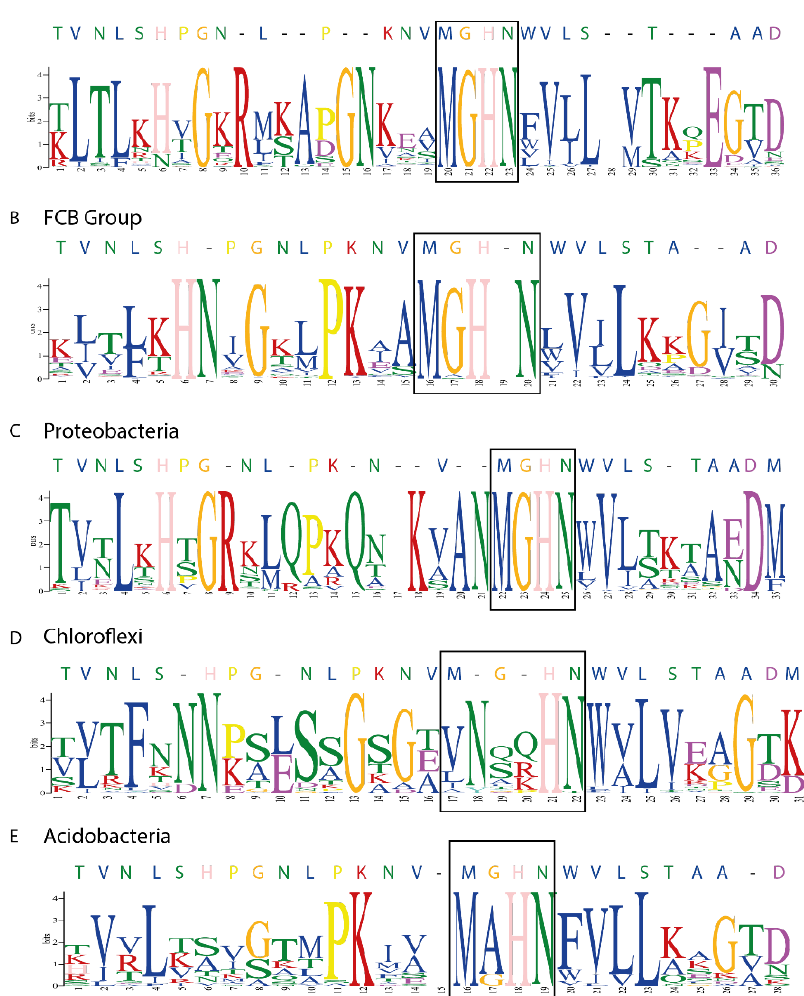
Figure 5. Logogram of p28 domain found in sequences of the major clusters. Logogram of the retrieved p28 domain in PVC superphylum ( A ), FCB group ( B ), Proteobacteria ( C ), Chloroflexi ( D ) and Acidobacteria ( E ). Size of each letter corresponds to the frequency of the related amino-acid in that position. Numbers on the X axis do not refer to the position on the sequence, but to the position of the retrieved alignment. Letters on top of each figure represent the corresponding amino-acid in the P. aeruginosa p28 domain. Black square frame indicates the MGHN tetrapeptide. Nevertheless, just 8 of the retrieved sequences from the phylum Chloroflexi were positive for its presence. Moreover, the p28 domains retrieved from the phylum Chloroflexi were more divergent in respect to the domains present in the other phyla, with even the MGHN tetrapeptide less conserved (Figure